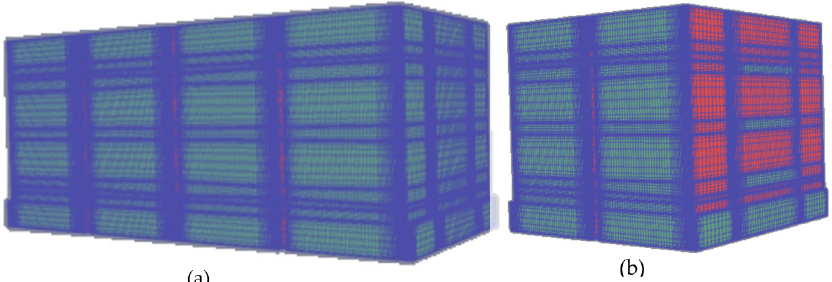
Figure 2. Computational mesh generated using the blockMesh utility for one of the finite slot width cases: ( a ) mesh geometry used for the full contact tank; ( b ) left half perspective of the contact tank mesh cut at the middle of the center vertical baffle.